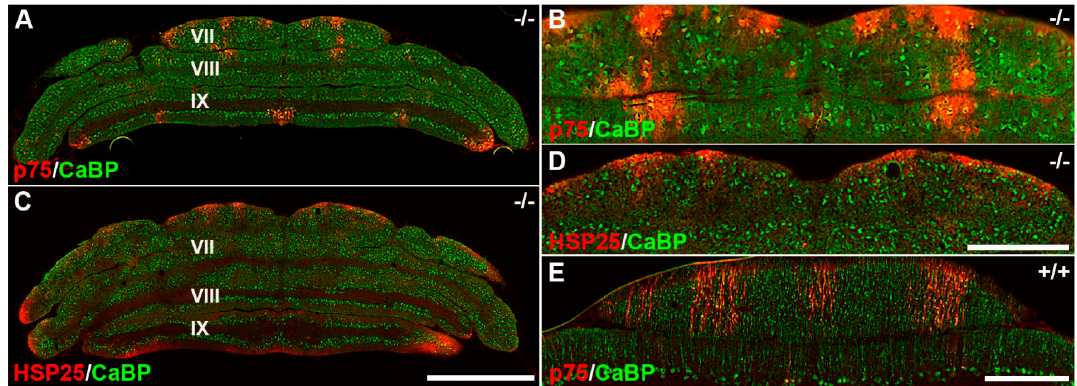
Figure 4. Transverse sections of nax − / − ( A – D ) and wt sibling cerebella at P22 immunostained with p75NTR, CaBP and HSP25. ( A , B ) P75NTR immunostaining shows an array of parasagittal stripes in